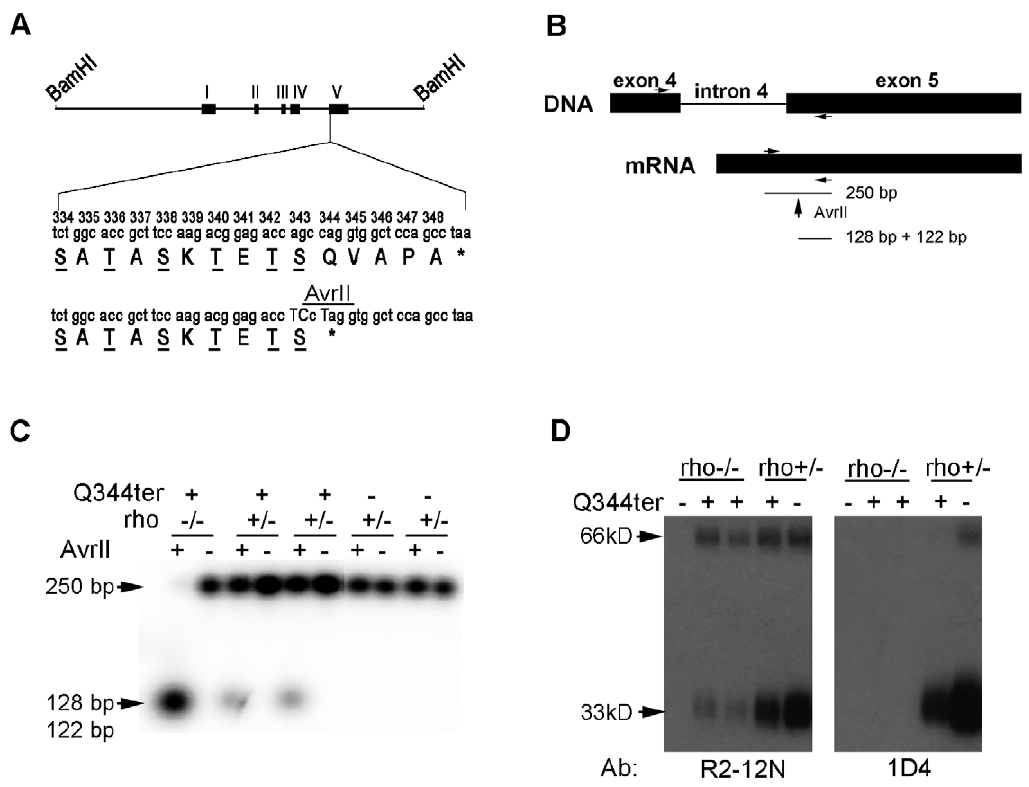
Figure 1. Generation of Q344ter transgenic mice. ( A ) Construct used to generate the Q344ter transgenic mice. In an 11-kb BamHI-flanked genomic clone containing the murine rod opsin gene, codon Q344 was mutated to an early stop signal (bottom *). The resulting rhodopsin mutant is missing the QVAPA domain but retains the six known potential phosphorylation sites (underlined). An AvrII site within the Q344ter transgene was generated by two silent mutations. Capitalized nucleotides denote the introduced point mutations. ( B ) Scheme to establish transcript expression level of the Q344ter transgene. The AvrII site is used to differentiate between Q344ter transgenic and WT transcript species. ( C ) Phosphor-image used to establish transgene-to-total rhodopsin transcript ratio. Total rhodopsin transcripts from each murine retina were amplified by RT-PCR and divided into two equal fractions. After AvrII digestion of one fraction, the enzyme-resistant 250 bp band is compared to the corresponding band from the undigested fraction. ( D ) Detection of the Q344ter mutant by western blot. Equal fraction (1/800) of a retina was loaded onto each lane. R2-12N monoclonal antibody recognizes the amino-terminus and identifies endogenous and Q344ter rhodopsin, while the 1D4 antibody recognizes only full length endogenous rhodopsin. Q344ter expression in rho 2 / 2 background was confirmed by R2-12N (left panel). As expected, these species were not detected by 1D4 (right panel). Monomeric and dimeric rhodopsin migrate at 33 kD and 66 kD, respectively.